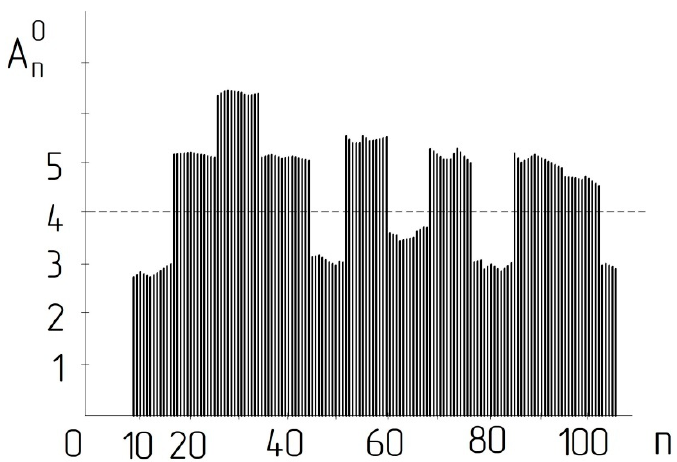
Figure 12. Spectrum of a rotor system with a rectangular modulation function and the system rotor disk at the number of places m = 276.